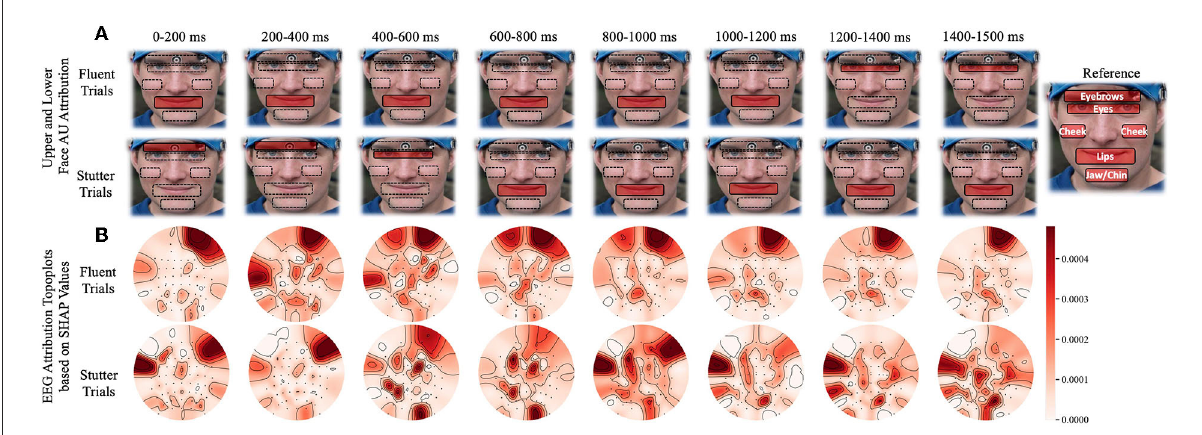
FIGURE4 Time window analysis of facial muscle movement and EEG activity with respect to predictions of fluent vs. stuttered trials. (A) Facial muscle movement attribution regions in the upper and lower face. The red highlighted regions show the areas with the most predictability in the upper or lower face. (B) Topographic plots showing levels of predictability of EEG signals (Shapley values). Circular topographic plots: up, frontal electrode sites; down, posterior sites, left and right correspond to the left and right scalp sites. AU, attribution unit; SHAP, Shapley.